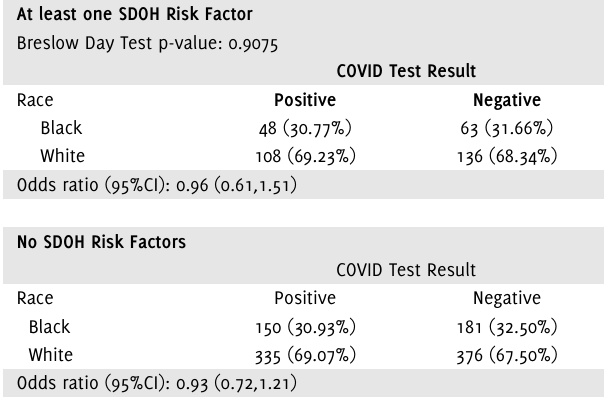
Table 4. Association Between Race and COVID-19 Status Stratified by SDOH Risk Factor At least one SDOH Risk